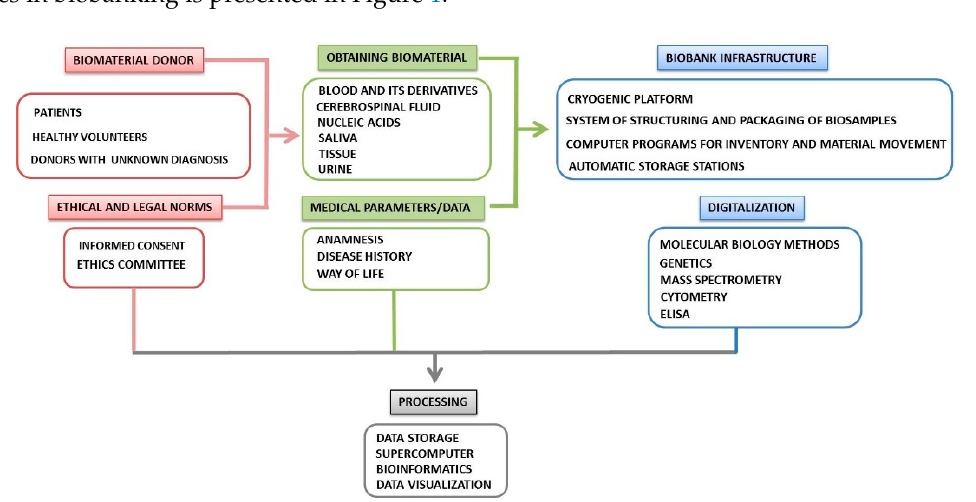
Figure 1. Key components of biobanking and routing scheme of biological samples.